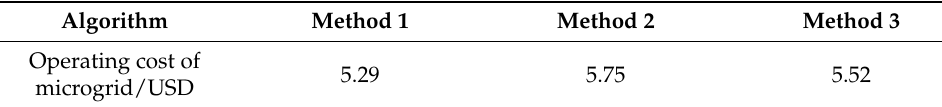
Figure 13. Scheduling results of microgrid using method 3. Table 4. Operating cost of microgrid using different algorithms.